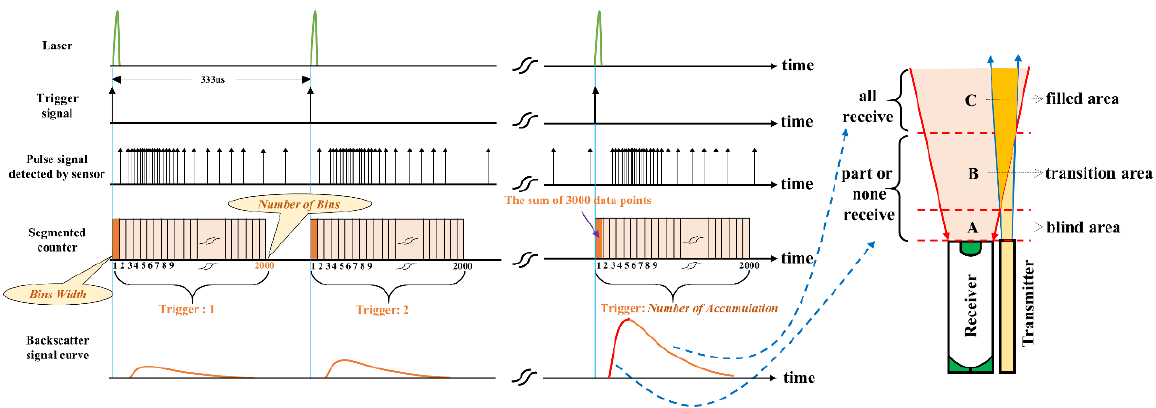
Figure 3. Block Schematic diagram of echo photon signal acquisition.